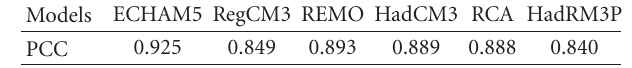
Table 5: Spatial pattern correlation coe ffi cient (PCC) over West Af- rica from individual GCM (ECHAM5 and HadCM3) and individ- ual RCM (RegCM3, REMO, HadRM3P, and RCA) rainfall with respect to GPCP. Models output are interpolated to GPCP